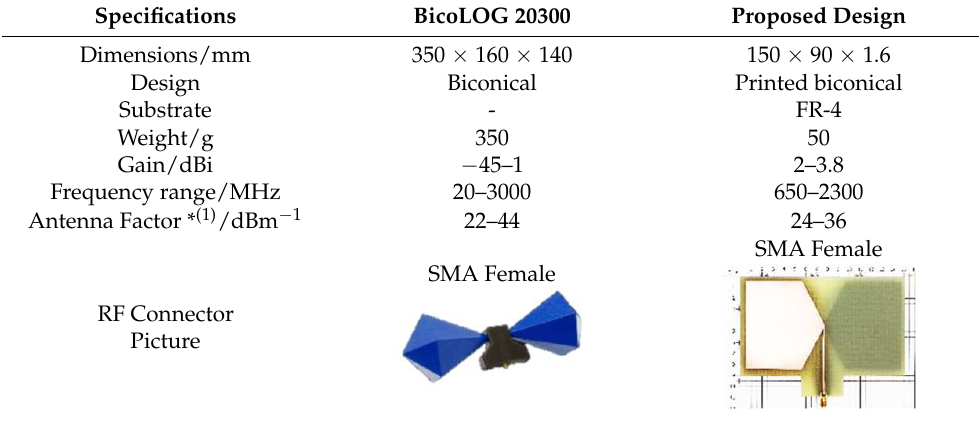
Table 3. Numerical comparison of antenna factor of the proposed antenna with the commercial antenna (BicoLOG 20300).